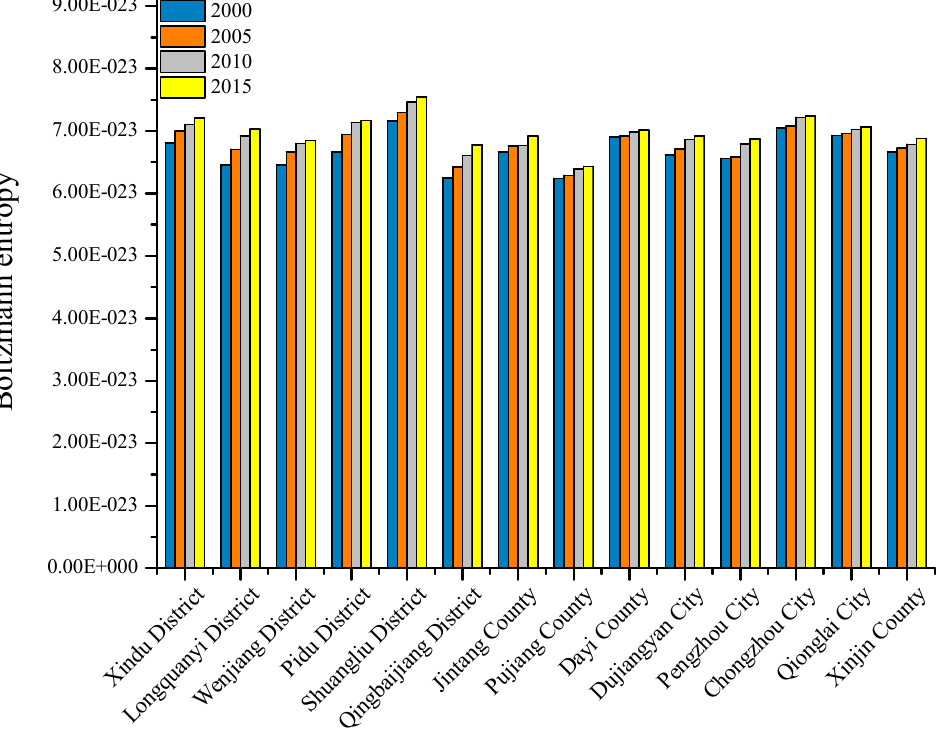
Figure 4. The Boltzmann entropy of built-up land from 2000 to 2015.